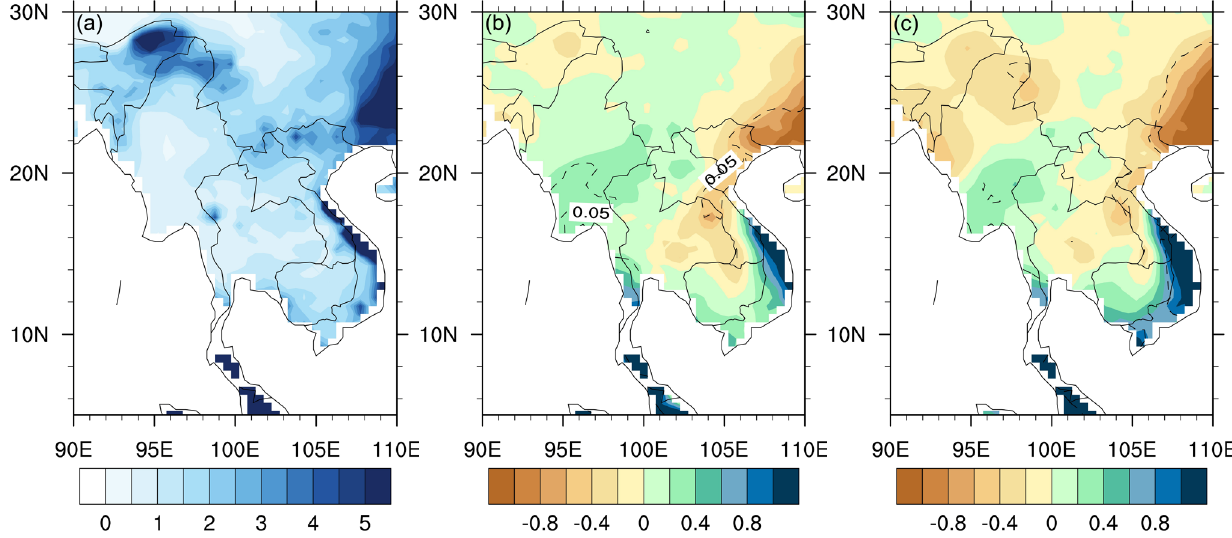
Figure 9. Spatial distributions of ( a ) climatic mean during the boreal winter of monthly total precipitation from 1979 to 2010, ( b ) the regressed precipitation anomaly on PC1pri, and ( c ) is the same as (b), but for the PC1sec. The shading color shows the regression results in units of centimeters per month, whereas the dashed line presents the significance level at